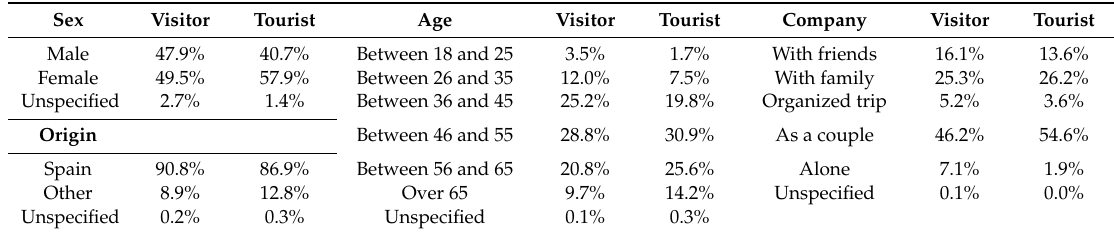
Table 4. Main characteristics of visitors to the